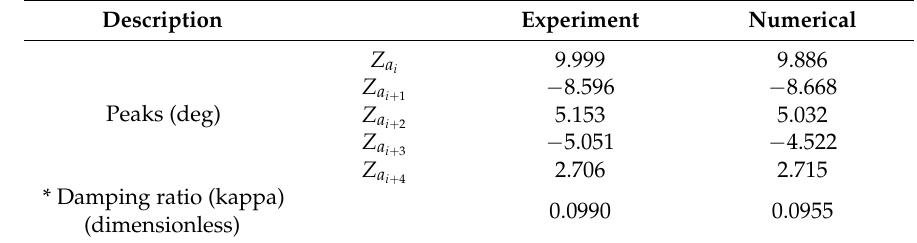
Figure 6. Initial position of the WEC rotor represented in the volume of fluid. Table 3. Comparison of the free decay test numerical simulations and experimental data for the WEC rotor.